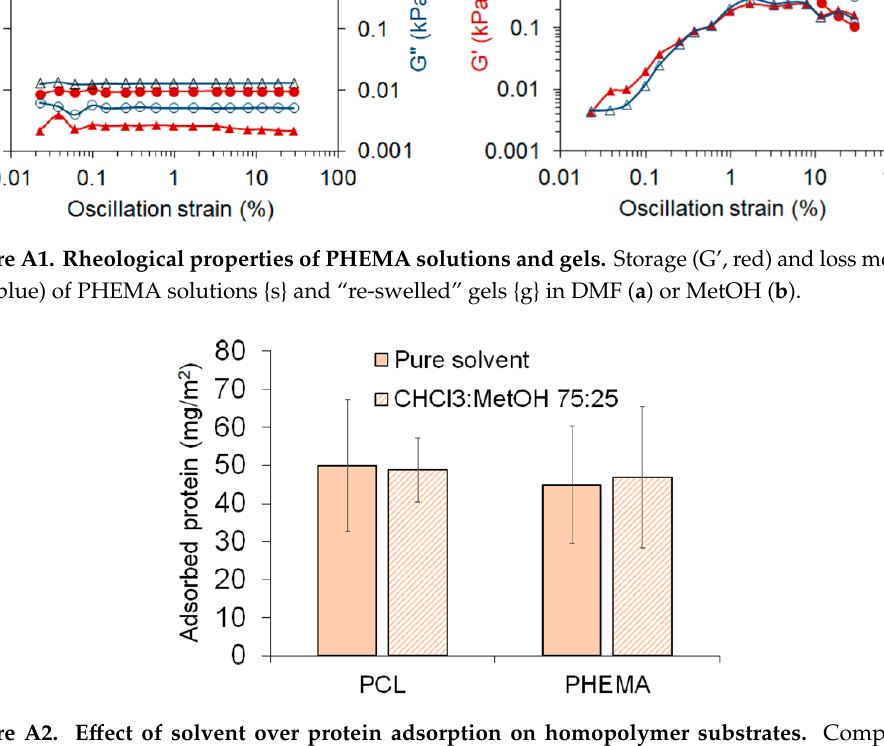
Figure A2. E ff ect of solvent over protein adsorption on homopolymer substrates. Comparison of serum protein adsorbed on substrates based in pure homopolymers (PCL = APsIPN100; PHEMA = APsIPN0). Pure solvents for PCL and PHEMA are CHCl 3 and MetOH, respectively.